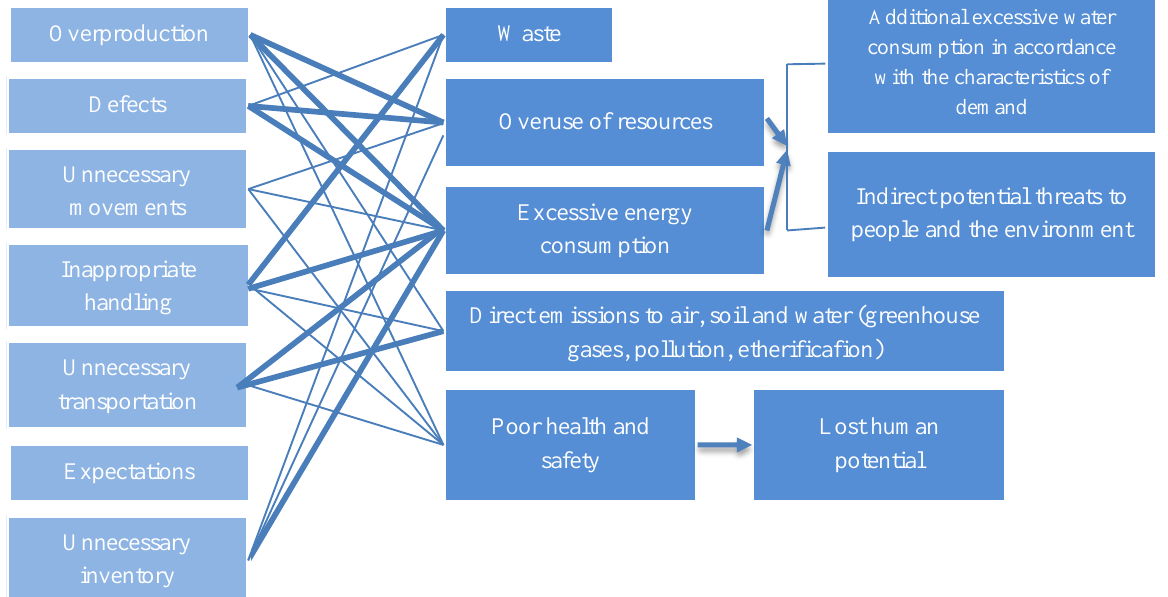
Figure 4. Causal relationships between lean construction and environmental losses.